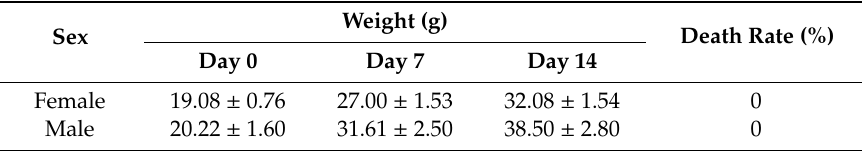
Table 1. The result of acute oral toxicity